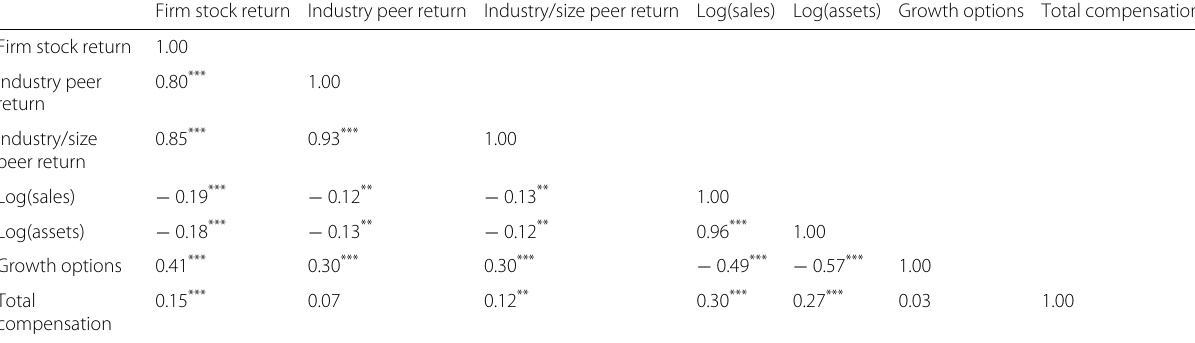
Table 7 Pearson correlation coefficients with regional peer